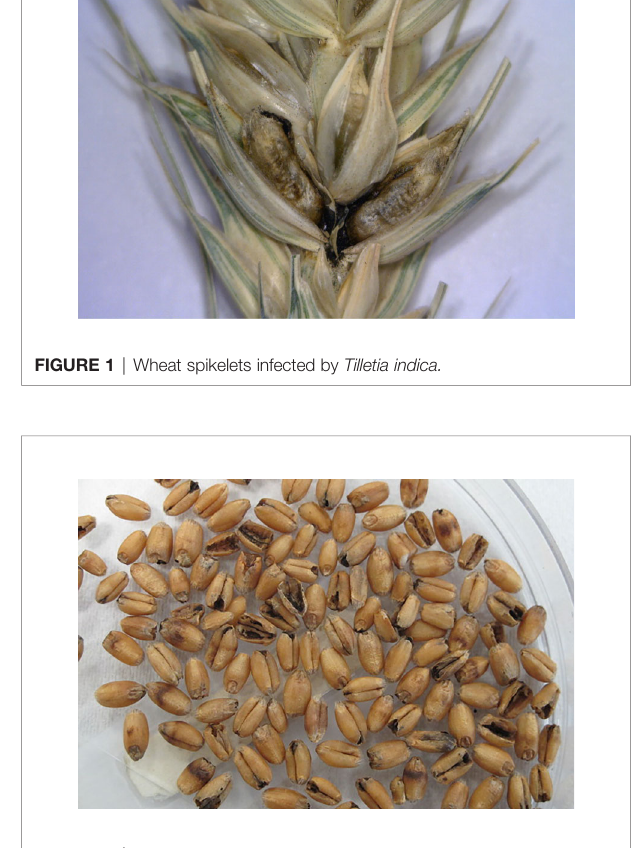
FIGURE 2 | Wheat kernels infected by Tilletia indica.